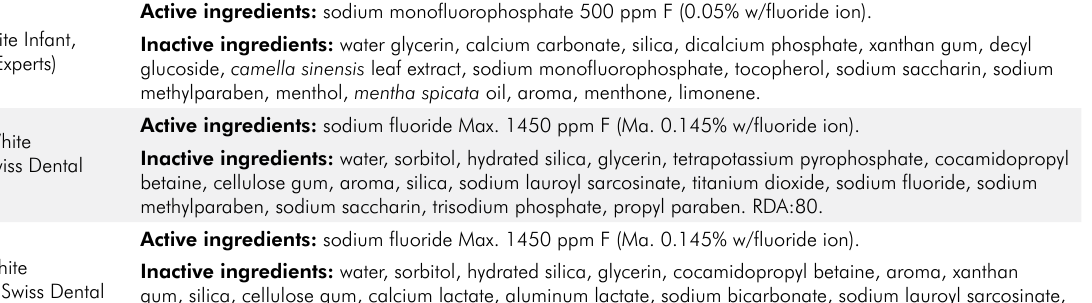
Table 1. Main ingredients of the tested toothpastes. Toothpastes